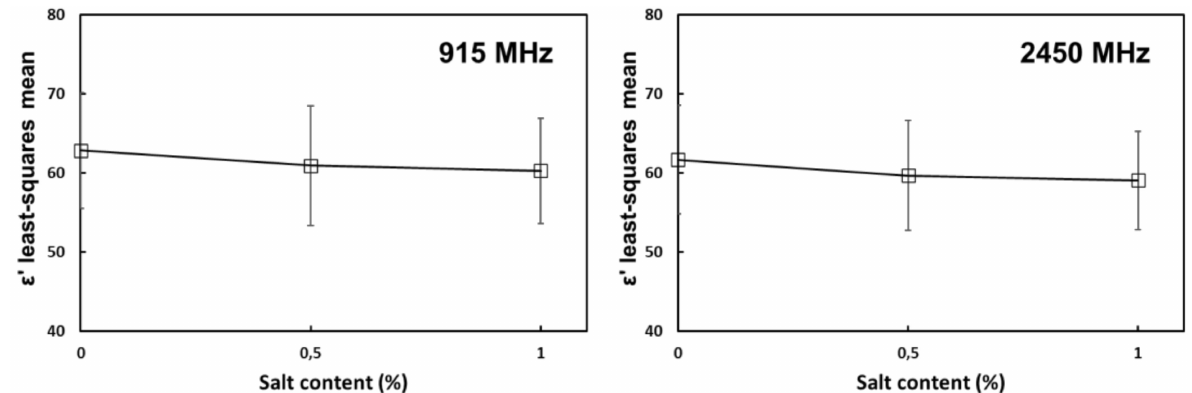
Figure 3. Main effect of salt content on the dielectric constant of tomato homogenate at 915 and 2450 MHz. Error bars correspond to standard deviations.